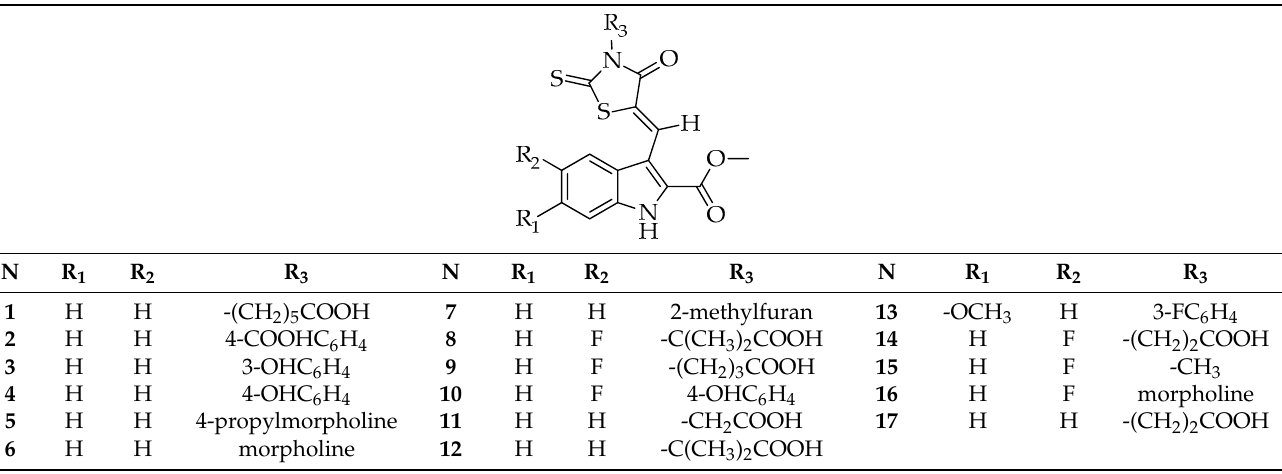
Table 1. The structures of evaluated compounds.